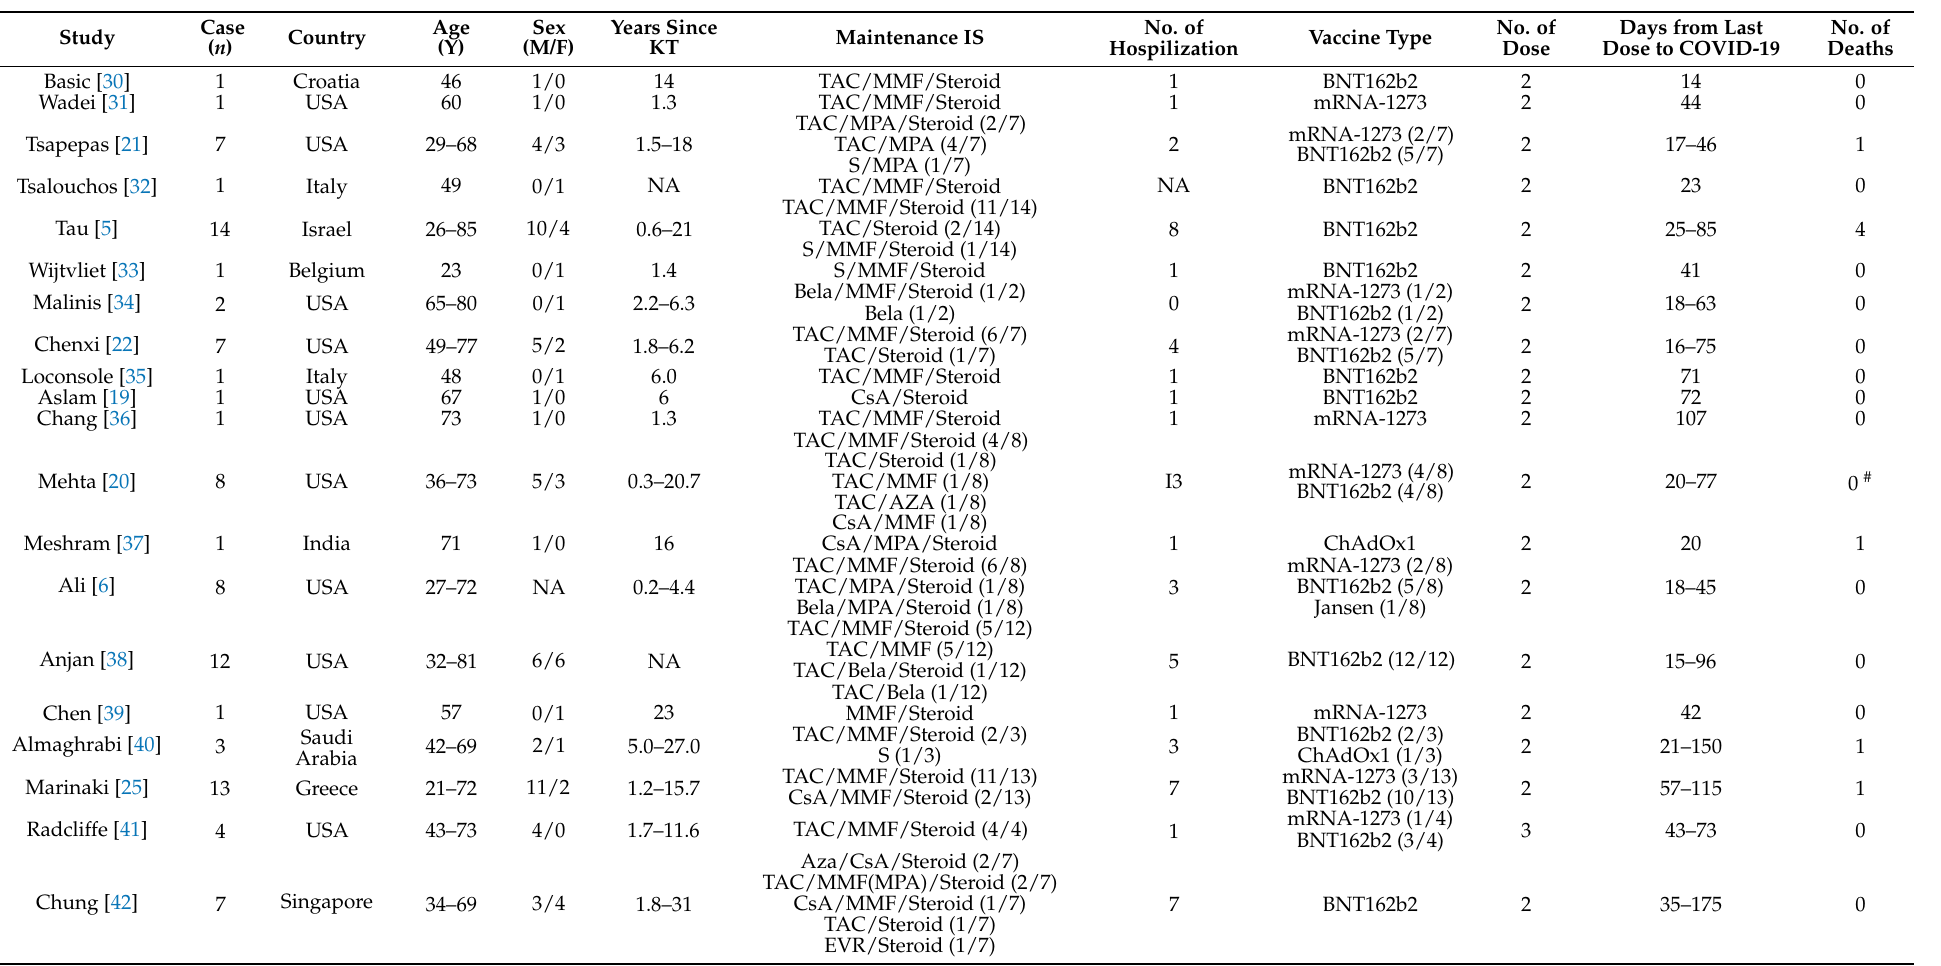
Table 2. Case and case series of COVID-19 breakthrough infections in vaccinated